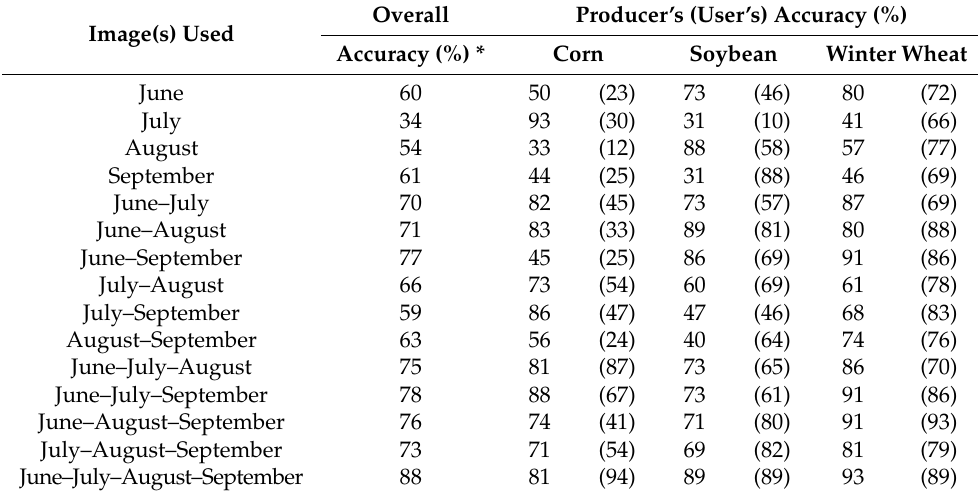
Table 9. Hyperion WekaXMeans Accuracies. Classification accuracies for WekaXMeans separating three leading world crops (corn, soybean, and winter wheat) using 15 Hyperion narrowbands. Analysis was conducted across 3 years, for 4 months throughout each growing season when available; these accuracies are averages across those 3